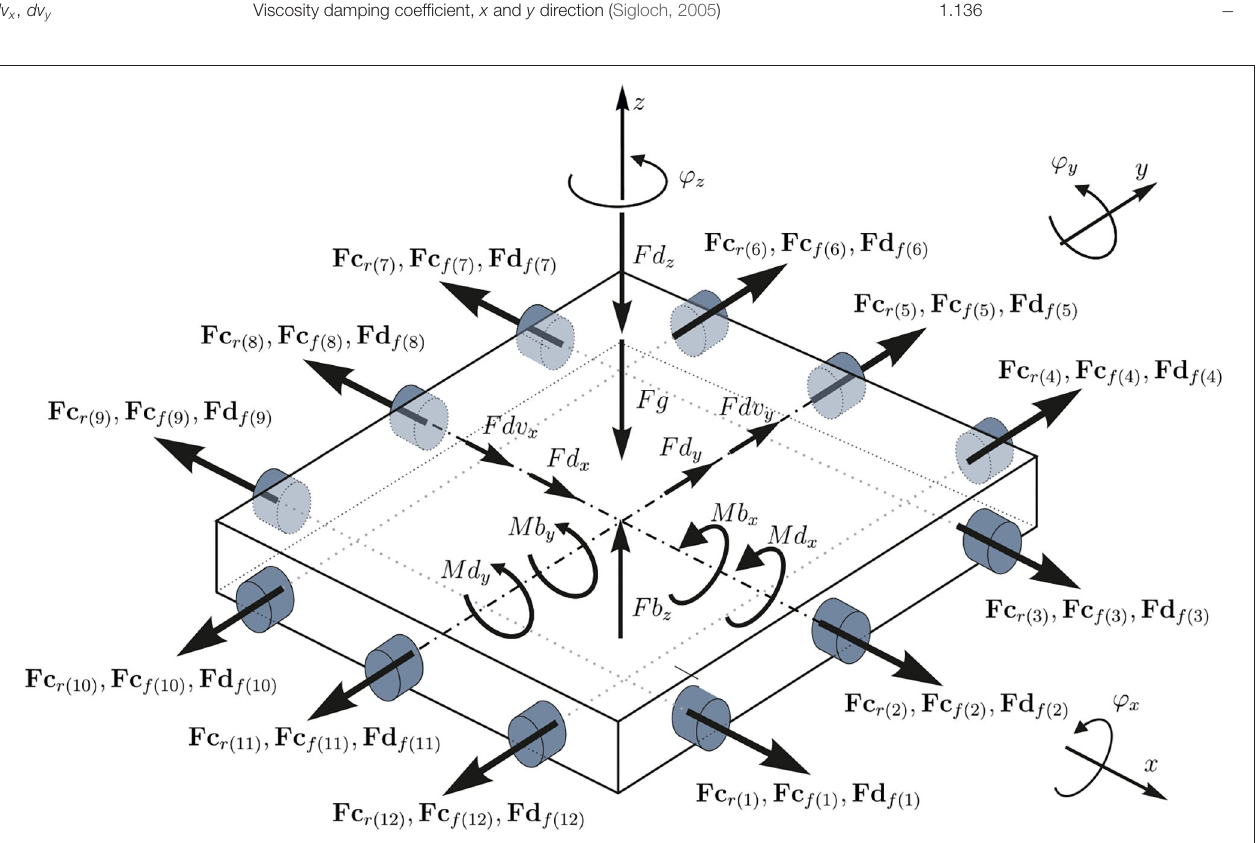
FIGURE 3 | Forces and moments acting on a single platform element with adjacent platforms on all sides and three fender per side area.